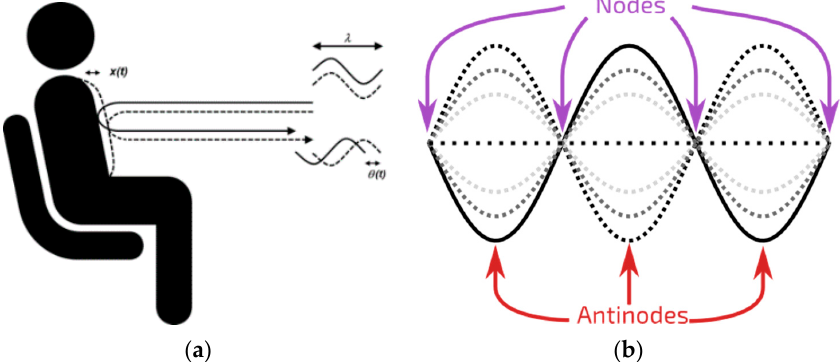
Figure 1. ( a ) Doppler effect: according to the Doppler effect, the phase change Δθ (t) of the reflected signal is proportional to motion of the measured location, scaled by wavelength of the signal Δθ (t)= 4 πΔ x(t)/ λ , where Δ x(t) is the chest displacement and λ is the wavelength of the transmitted signal; ( b ) Standing wave: the figure shows a possible sinusoidal standing wave. The different lines show the standing wave at different moments in time.